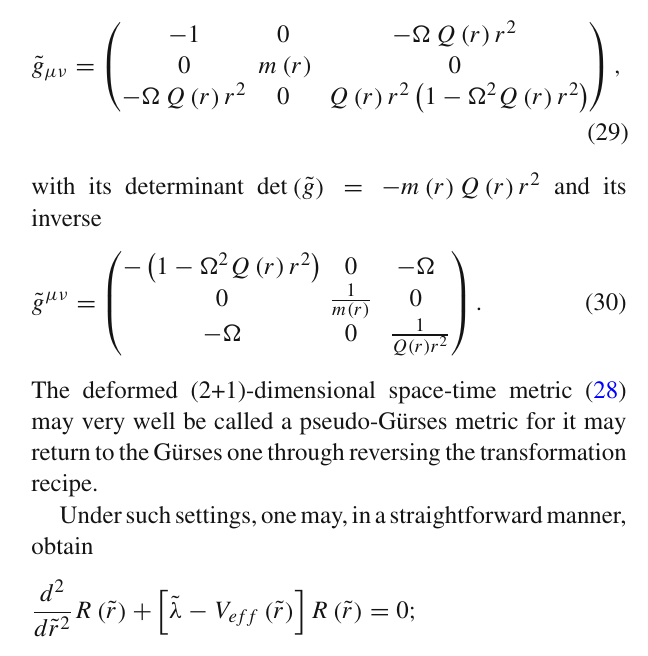
Then the corresponding confined KG-oscillator is given,